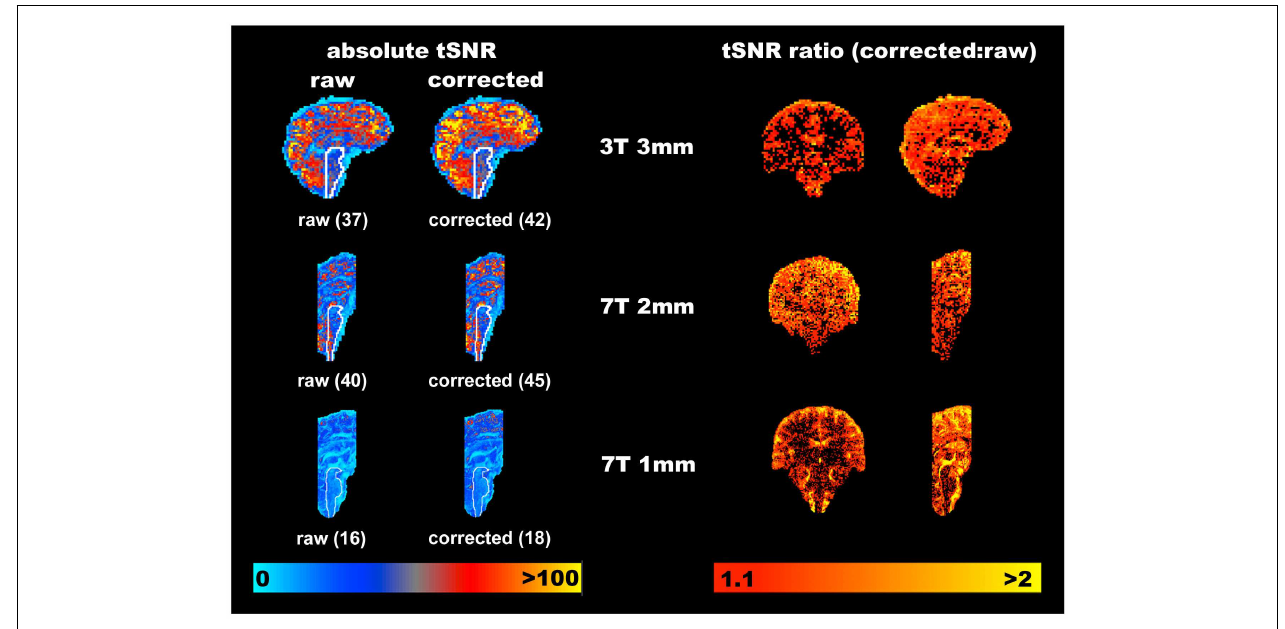
corrected to raw tSNR, and are thresholded at 1.1 to indicate where one might reasonably expect to see improvement of greater than 10% in the measured tSNR. Clearly the cortex appears to benefit most from this correction with increases in tSNR of 100% frequently observed at all resolutions and field strengths.The improvement in the brainstem is more modest, but nonetheless improved on average by at least 12.5% in this area (for all